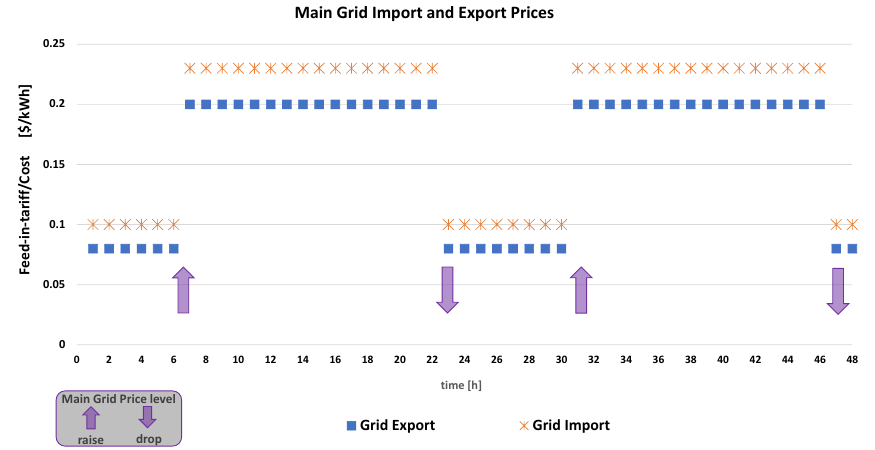
Figure A6. Data Input for FiT and BPT for Section